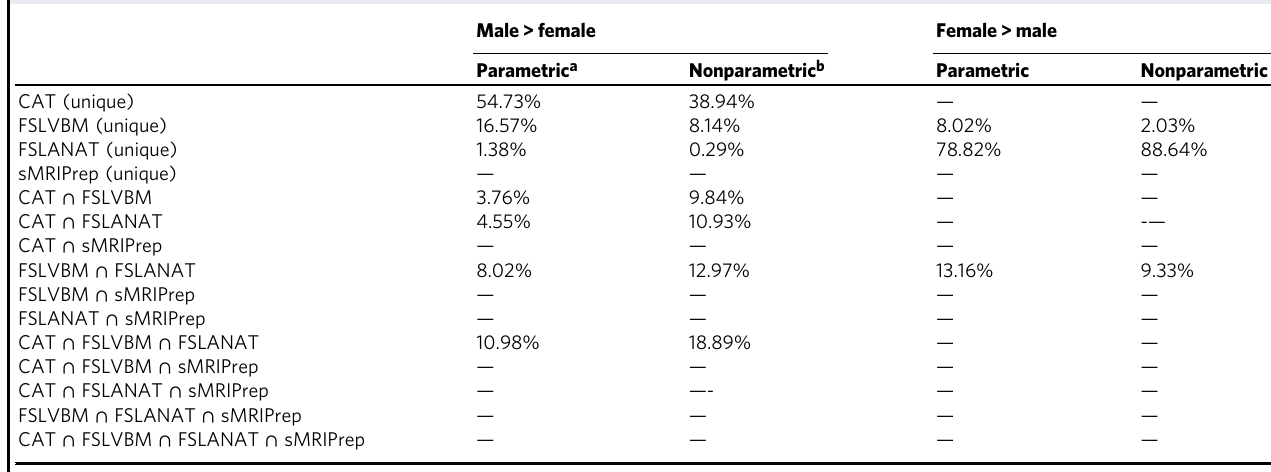
Table 1 Percent overlap of GMV sex-differences as revealed by the four